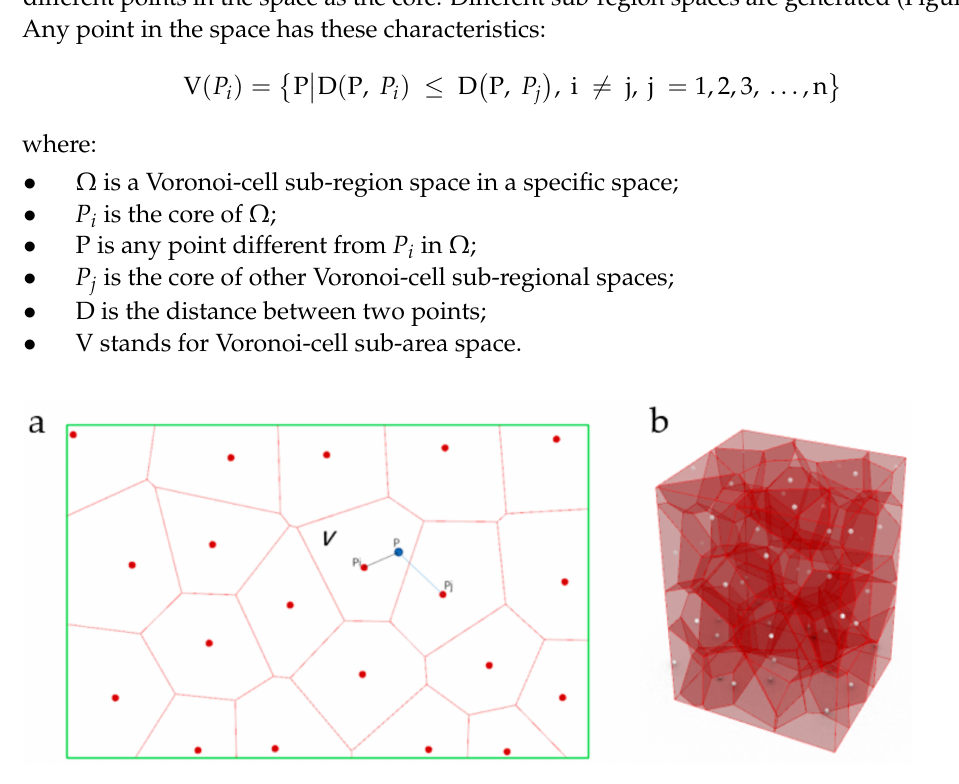
Figure 2. Schematic diagram of Voronoi-cells: ( a ) Two-dimensional Voronoi-cells; ( b ) Three- dimensional